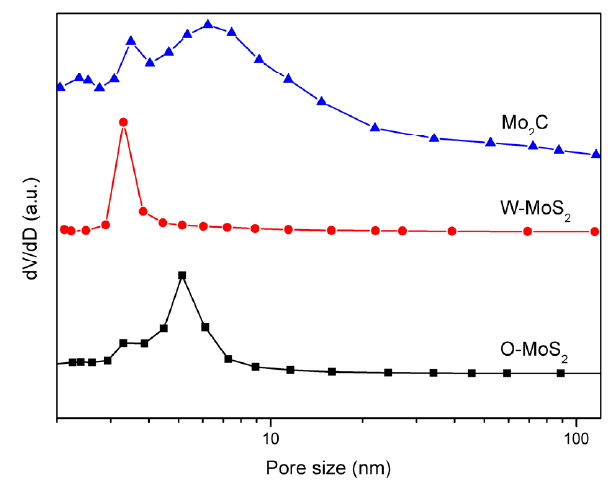
Figure 5. Pore-size distribution curves of catalyst samples.